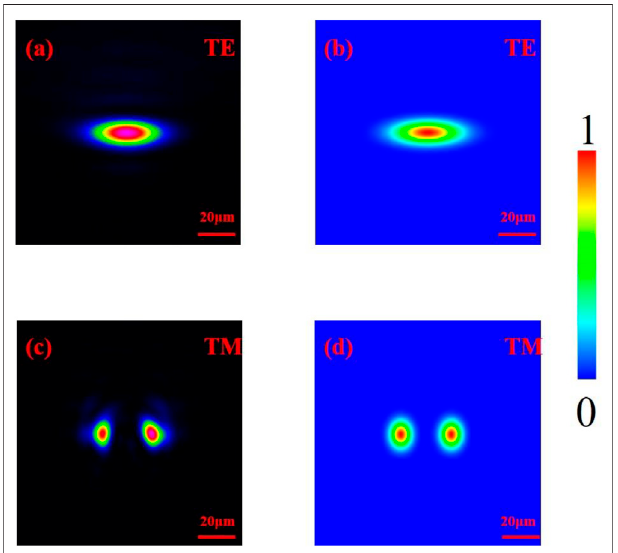
FIGURE 3 | Measured near- fi eld modal pro fi les (A) (C) and simulated modal pro fi les by using FD-BMP code (B) (D) of the ridge waveguide at 4 μ m wavelength.